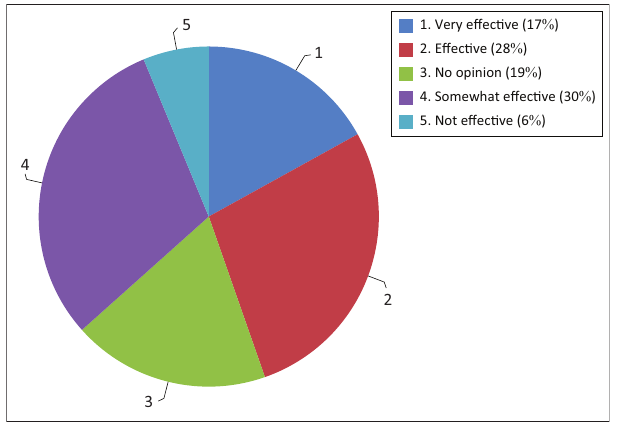
FIGURE 5: Participants’ opinions of knowledge repositories as knowledge transfer tools ( n = 112).